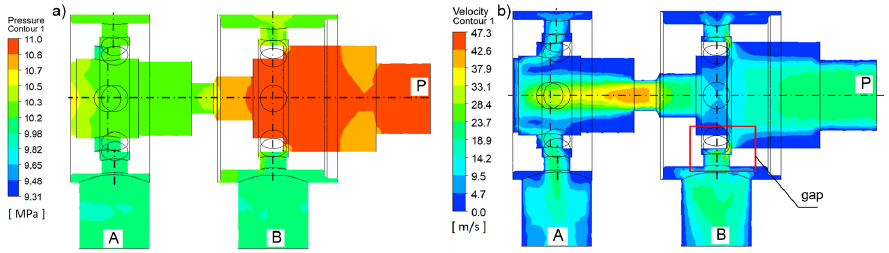
Figure 8. CFD results for equal loads on both outputs in the longitudinal cross-section: ( a ) pressure distribution, ( b ) velocity distribution; P, A, B—connection ports.